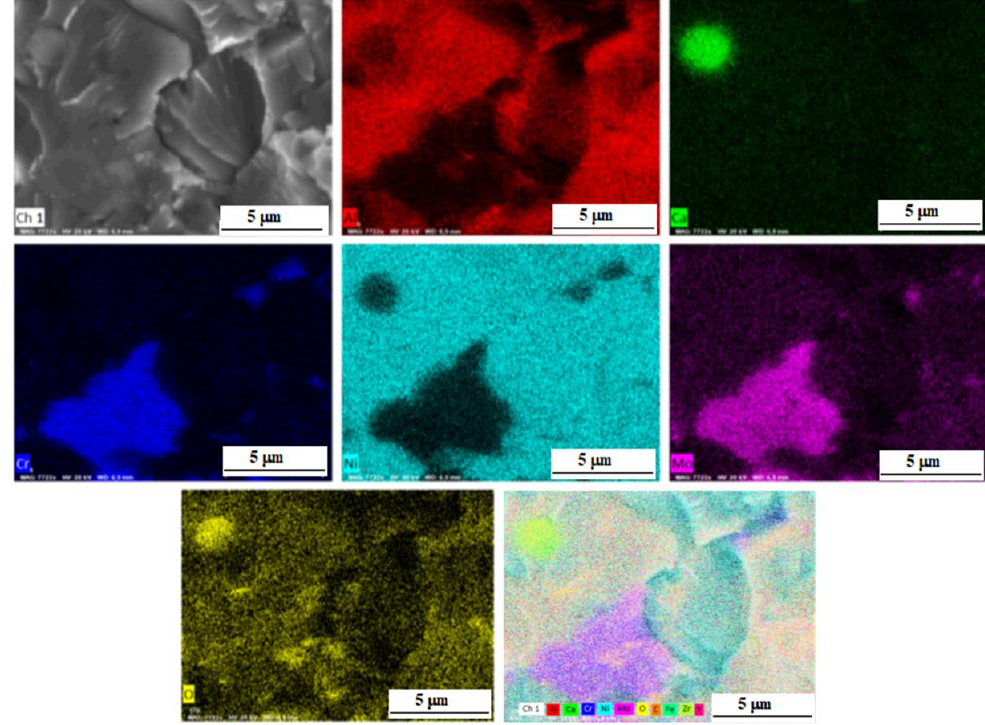
Figure 8. SEM secondary electron image, maps of the elements distribution in the sample M-0.05 wt.% ZrO 2 and a summary map.